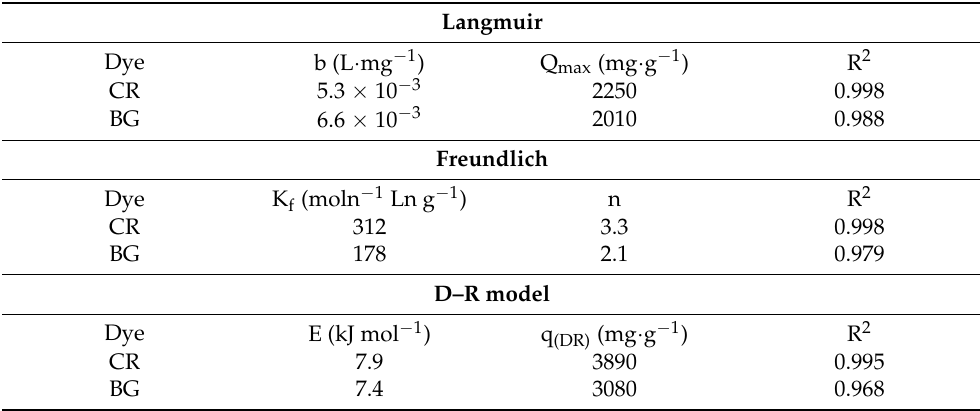
Table 2. Calculated parameters of the Langmuir, Freundlich, and Dubinin–Radushkevich (D–R) models for the adsorption of CR and BG dyes on the NLS/Cs/Alg.